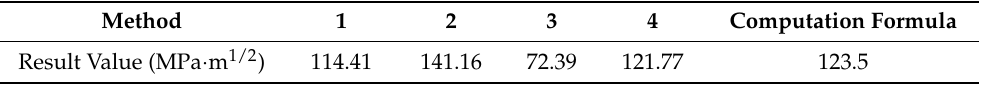
Table 3. Comparison of the calculation results for four different